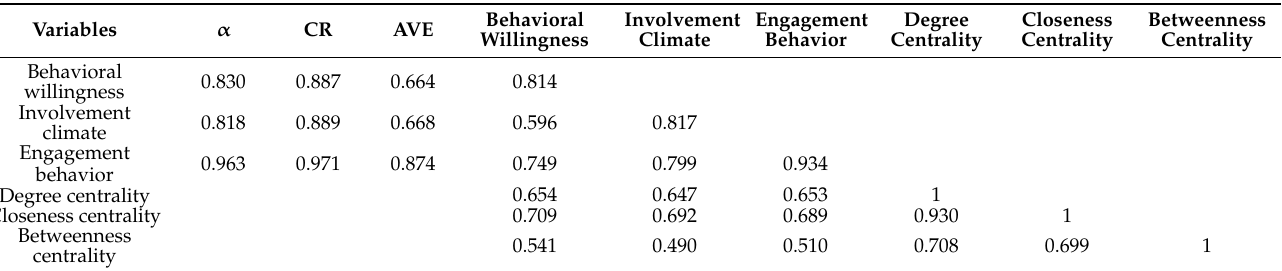
Table 3. Results of reliability and validity tests of the